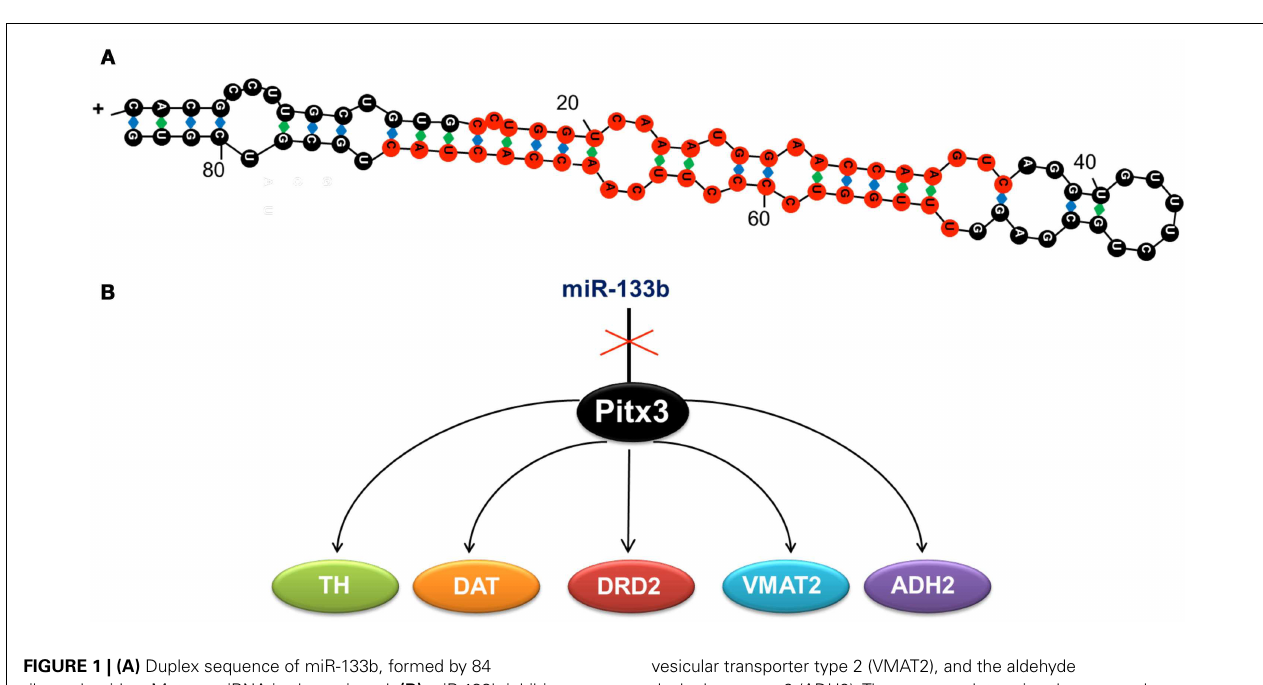
FIGURE 1 | (A) Duplex sequence of miR-133b, formed by 84 ribonucleotides. Mature miRNA is shown in red. (B) miR-133b inhibits the expression of transcription factor Pitx3, whose function is to activate the expression of tyrosine hydroxylase (TH), the dopamine transporter (DAT), the dopaminergic receptor (DRD2), the monoamine